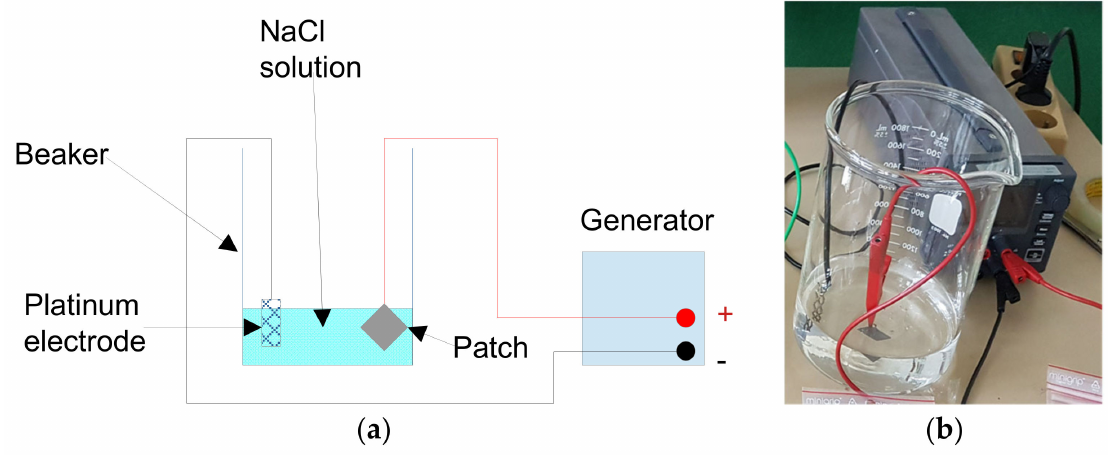
Figure 6. ( a ) Scheme and ( b ) picture of the accelerated corrosion